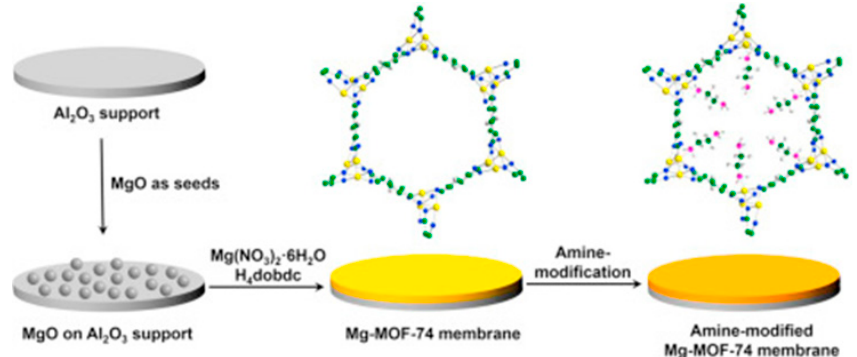
Figure 33. Scheme of the synthesis of Mg-MOF-74 membrane on MgO-seeded Al 2 O 3 supports and amine-modification of the as-prepared Mg-MOF-74 membrane. (adapted with permission from ref. [77]).